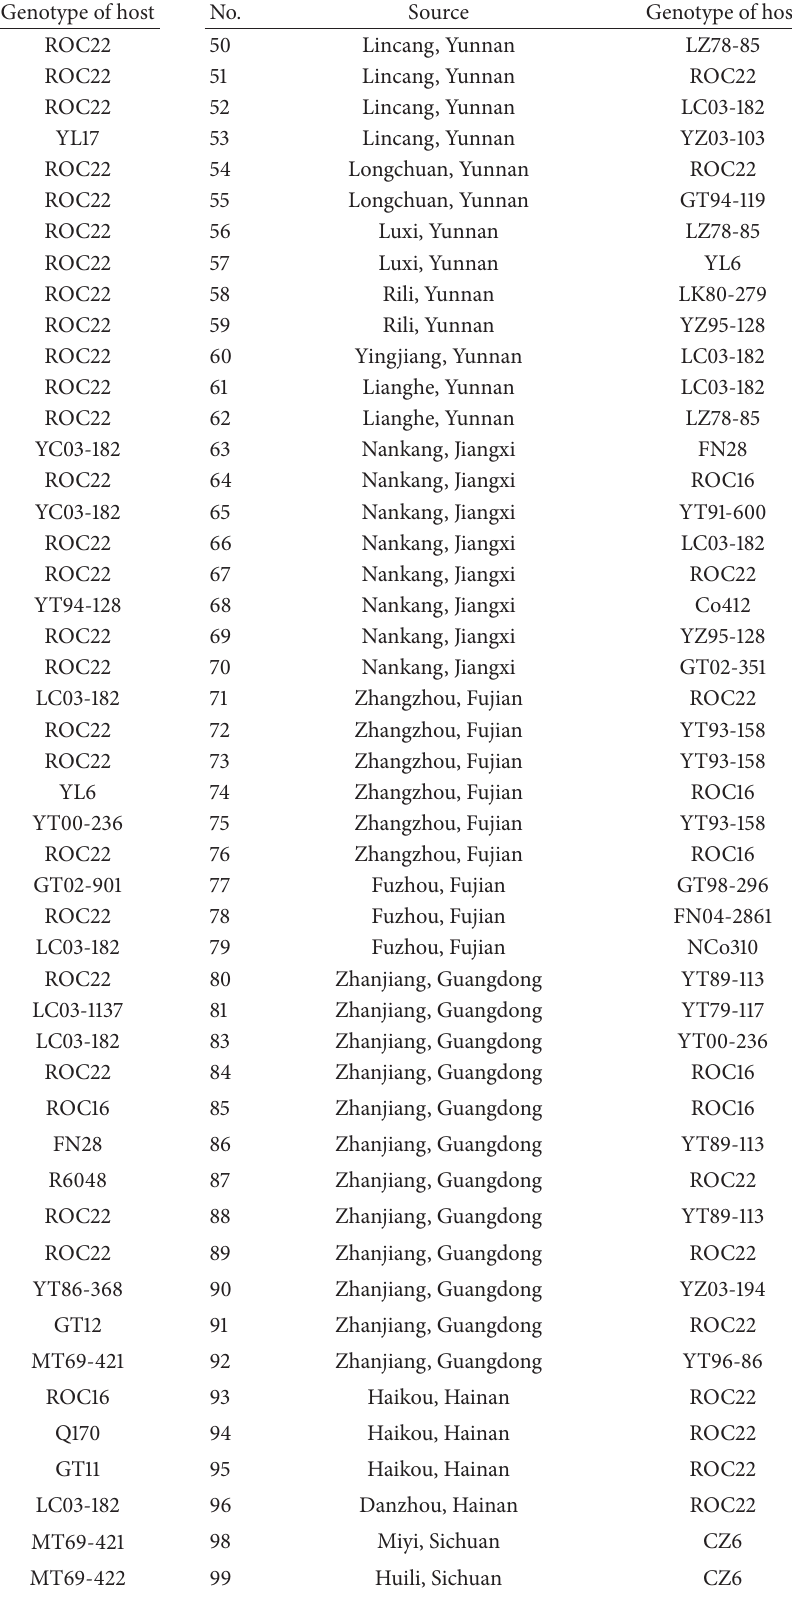
Table 1: Information about 100 strains of S. scitamineum